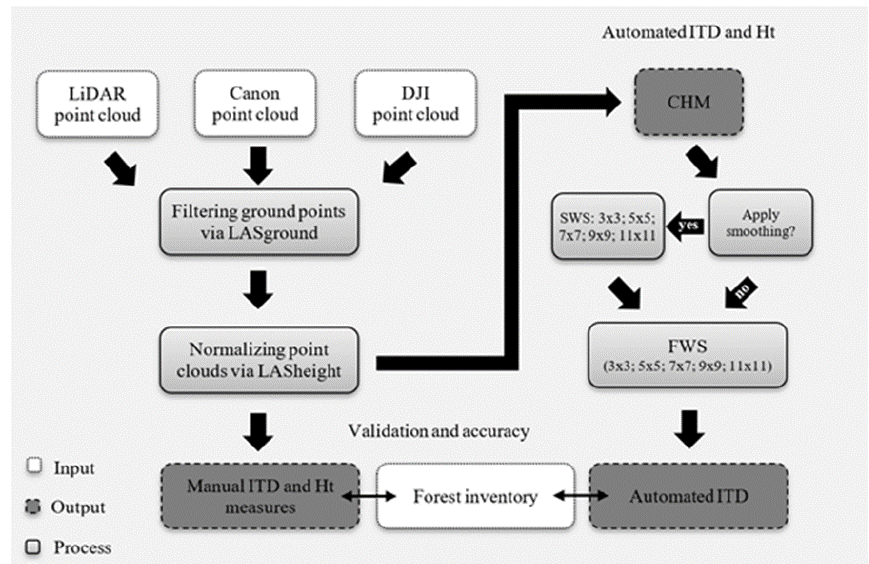
Figure 2. Data processing workflow showing the steps taken from point cloud processing, canopy height model (CHM) generation, smoothing window sizes (SWS), search window sizes (FWS), to individual tree detection (ITD) and tree height (Ht) measurement and validation against the timber cruise. This flow chart includes the workflows for both the manual and automated tree mensuration detailed in this study. (This workflow excludes the steps taken to generate the point clouds, which are detailed in Section 2.3.)